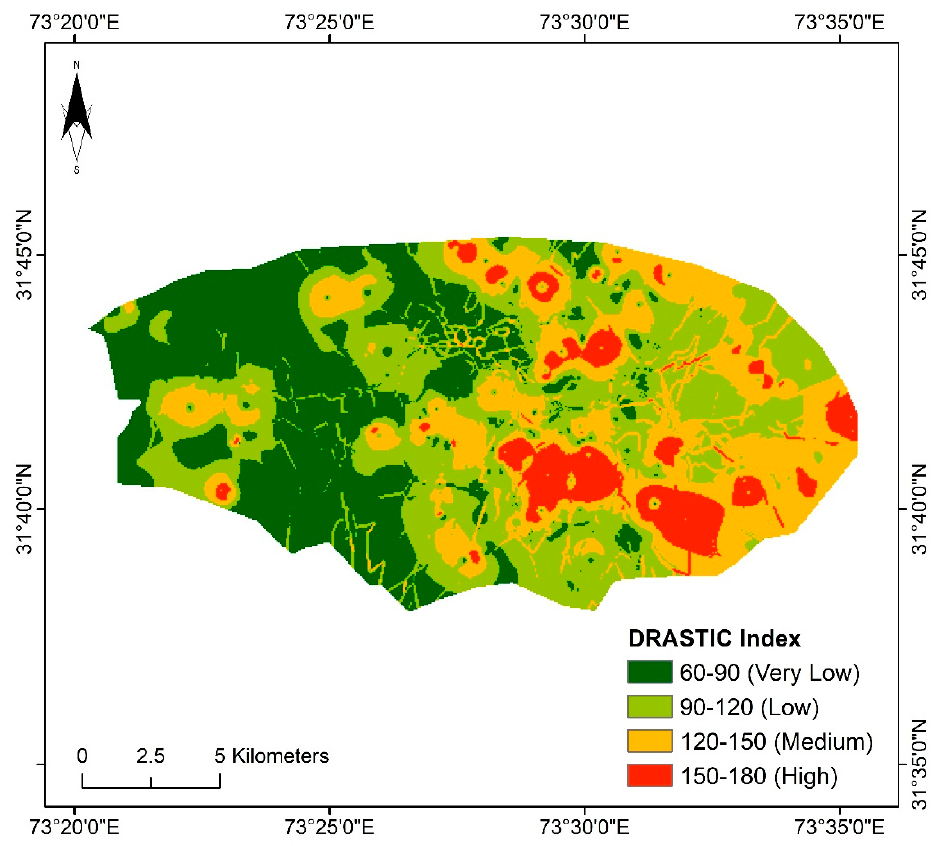
Figure 3. Drastic vulnerability map of the area.